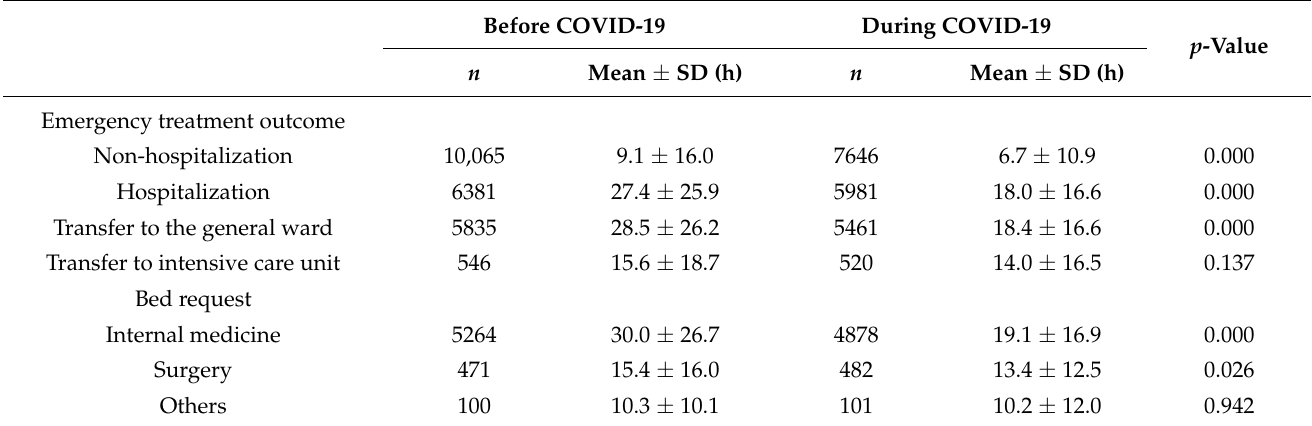
Table 3. Comparison of elderly patients’ and boarded patients’ length of stay in the emergency department (ED) during the COVID-19 pandemic versus during the pre-pandemic period. Before COVID-19 During COVID-19